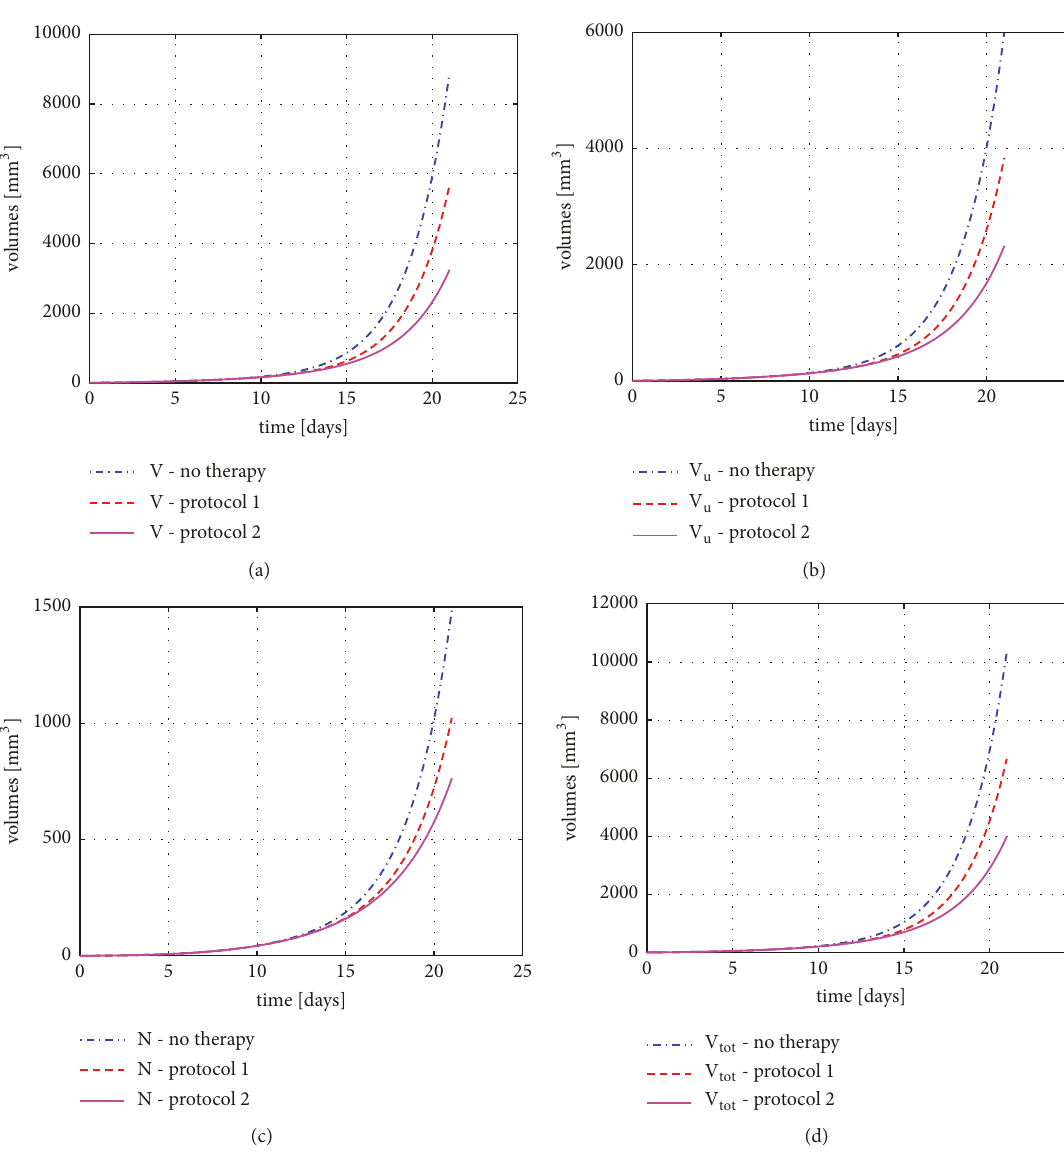
Figure 7: Volume trajectories of the model (living volume 𝑉 , unsupported volume 𝑉 𝑢 , necrotic volume 𝑁 , and total volume 𝑉 𝑡𝑜𝑡 , corresponding to subfigures (a), (b), (c), and (d), resp.) in the case of various therapies.